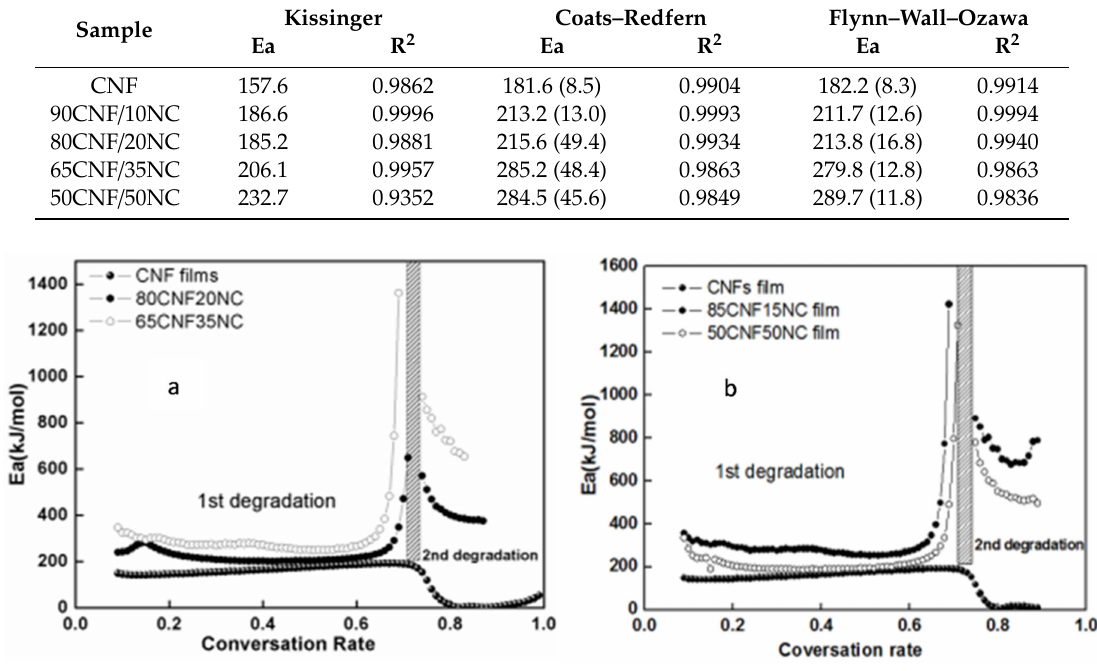
Figure 10. Ea for selected samples calculated by ( a ) modified the Coats–Redfern ( b ) Flynn–Wall–Ozawa